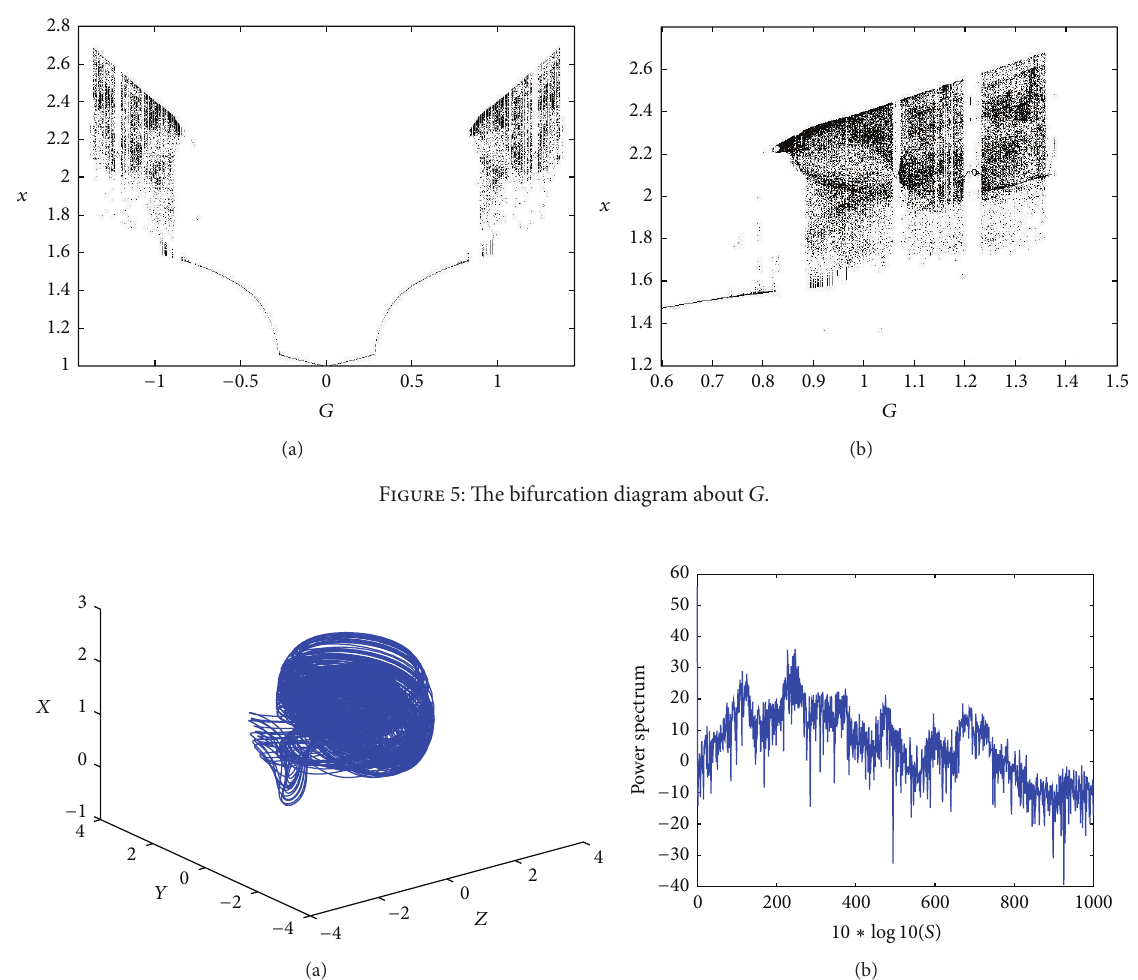
Figure 6: (a) Phase portraits of the chaos attractor. (b) Spectrum of 𝑥 .